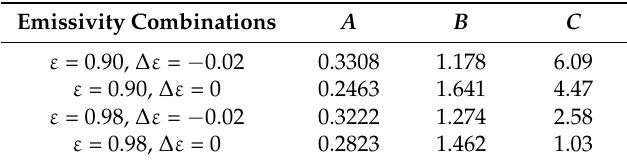
Table 3. A , B and C in Equation (1) for different emissivity combinations.